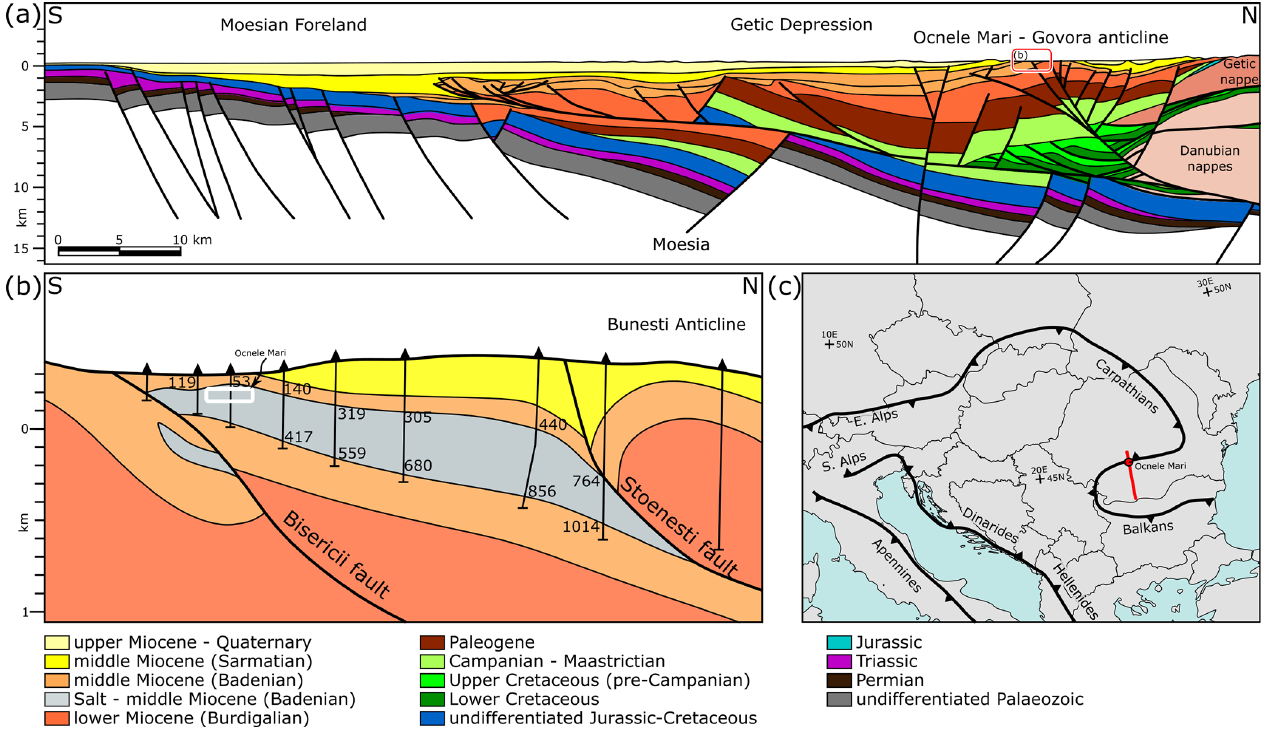
Figure 1. (a) Regional geological profile of the area (after R˘ab˘agia et al., 2011, and references therein). The location of the local profile (b) is marked with a red rectangle. Coordinates of the two ends of the profile are north 45 ◦ 20 (cid:48) 51 (cid:48)(cid:48) N 24 ◦ 19 (cid:48) 51 (cid:48)(cid:48) E and south 43 ◦ 47 (cid:48) 11 (cid:48)(cid:48) N 24 ◦ 31 (cid:48) 43 (cid:48)(cid:48) E. (b) Local geological profile of the Ocnele Mari area, illustrating the shape and position of the salt body (45 ◦ 05 (cid:48) 06.9 (cid:48)(cid:48) N 24 ◦ 18 (cid:48) 33.7 (cid:48) "E) (after Stoica and Gherasie, 1981) with the location of wells, on which the profile is based. The numbers indicate the top and bottom of salt (in measured depth). The approximate location of the mine is marked with a white rectangle. (c) Sketch of main structural features of the Alpino–Carpatho–Dinaric region. The location of the regional profile (a) is marked with a red